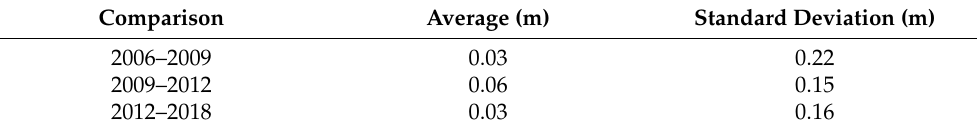
Table 5. Average and standard deviation of the vertical comparison between subsequent LiDAR surveys performed on PRD in stable areas (portions of Albarella island and Barricata village).